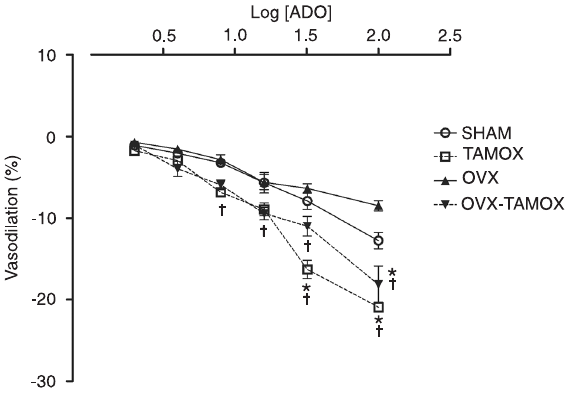
Figure 3. Coronary perfusion pressure values reported as a percentage of coronary vascular bed dilatation with increasing concentrations of adenosine (ADO) in the four treatment groups (SHAM, TAMOX, OVX, and OVX+TAMOX; for abbreviations, see legend to Table 1). Data are reported as means ± SEM (N = 7 rats in each group). *P < 0.05 compared to the SHAM group; † P < 0.05 compared to the OVX group (ANOVA followed by the Tukey post hoc